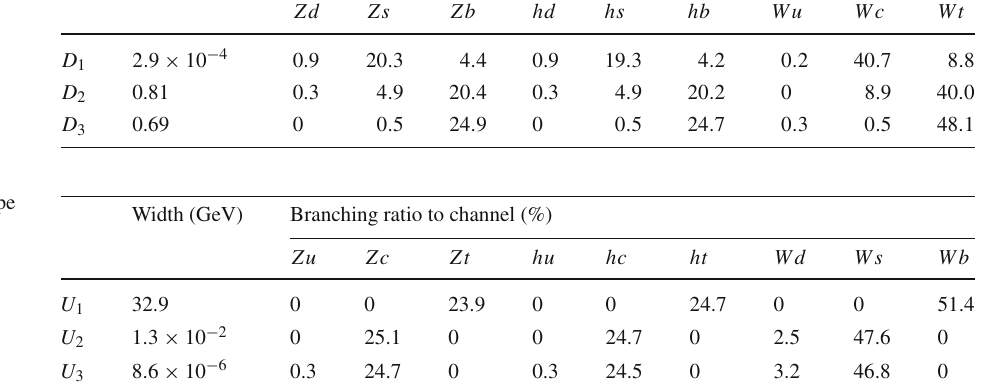
Table 3 Decays of new down-type quarks